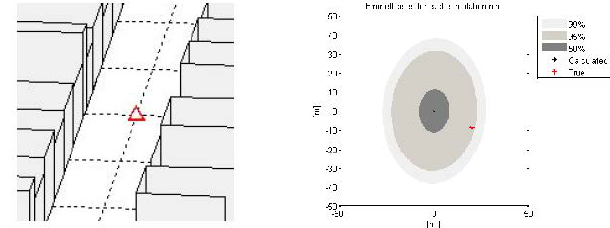
Figure 6: Street located in North-South direction between buildings (left), illustration of position error (right).